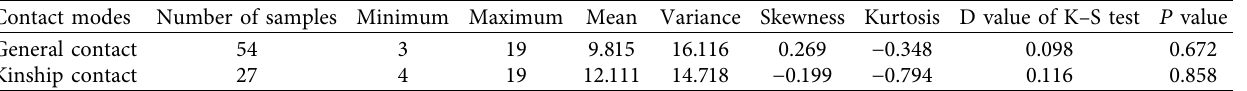
Table 5: Statistical characteristics and normal distribution test of incubation time of different contact modes. Contact modes